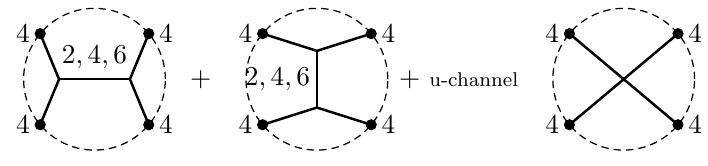
Figure 2 . Tree diagrams contributing ⟪ ϕ 4 ϕ 4 ϕ 4 ϕ 4 ⟫